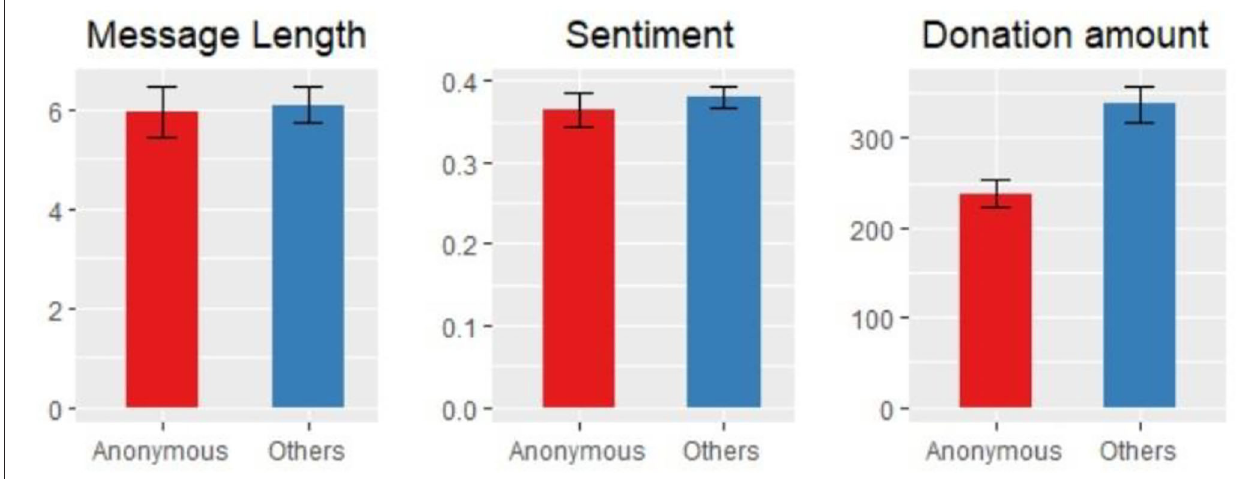
FIGURE 3 | Donation behavior of anonymous and non-anonymous donors (histograms represent arithmetic means; error bars represent standard